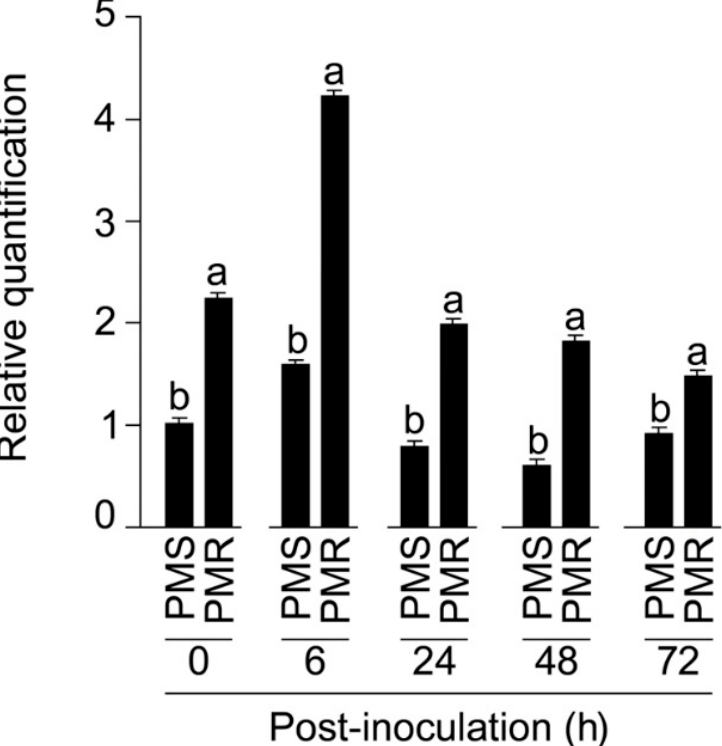
Figure 6. Expression of the CmoAP2/ERF gene in PMS and PMR lines at different time intervals post-PM infection. Relative expression of CmoAP2/ERF gene in PMS and PMR lines in response to PM pathogen infection. The CmoActin gene was used as an internal control for normalization. For each experiment, the expression level of the PMS sample prior to pathogen treatment was used as a calibrator for quantification and was assumed as 1. Values are means ± SE ( n = 3), and different letters on the bars indicate that the values differ significantly ( p < 0.05).